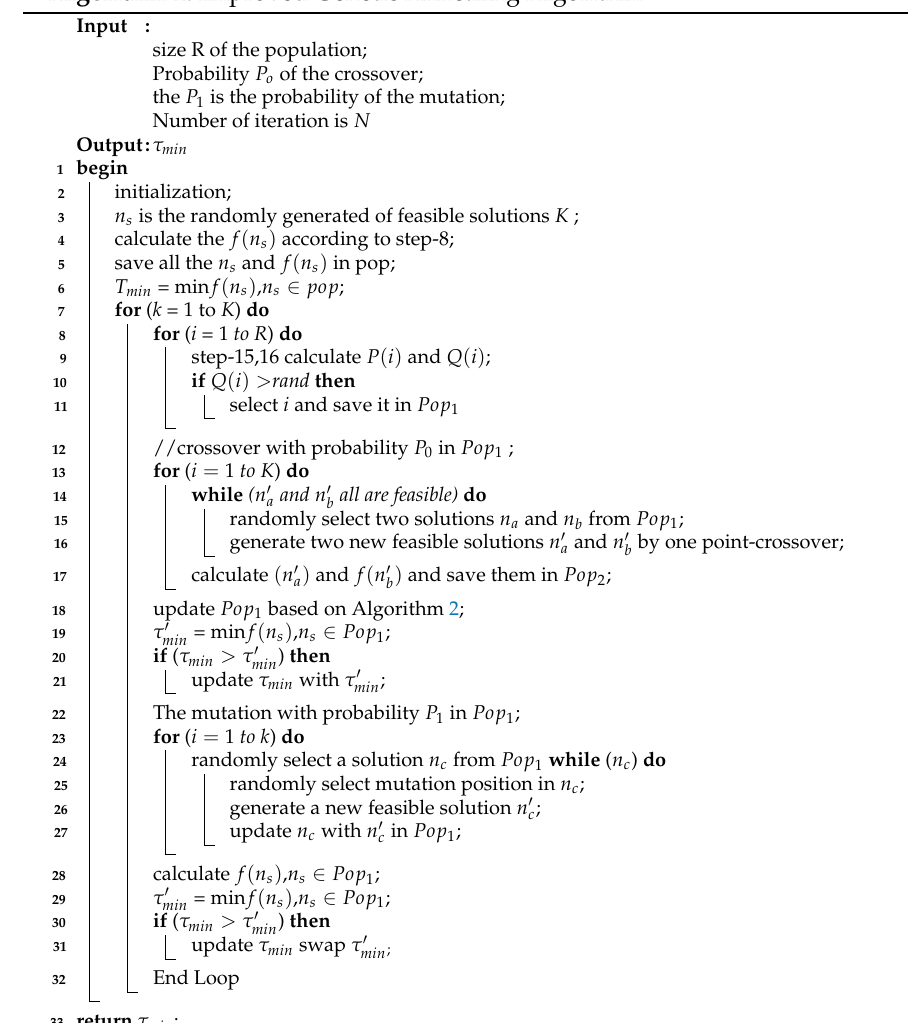
Algorithm 2: Improved Genetic Annealing